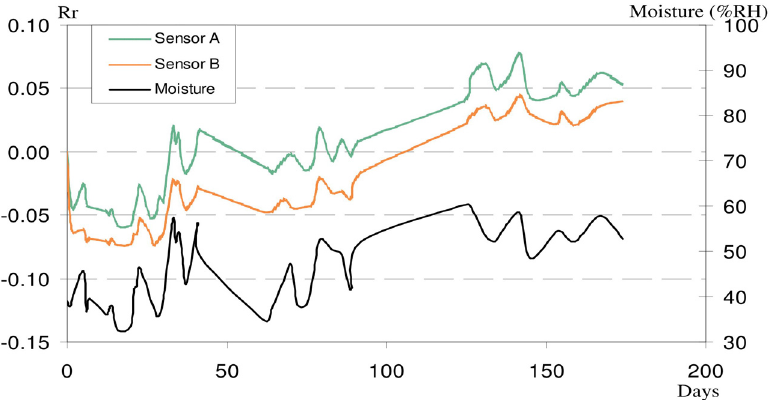
Figure 4. Variation of electrical resistance of sensors vs. aging and ambient